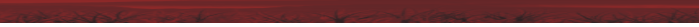
Figure 8: Probable causes (white boxes) of increasing moose population and its impact (yellow boxes) on Scots pine establishment above the present upper limit of mature pines in Utsjoki, northern Finnish